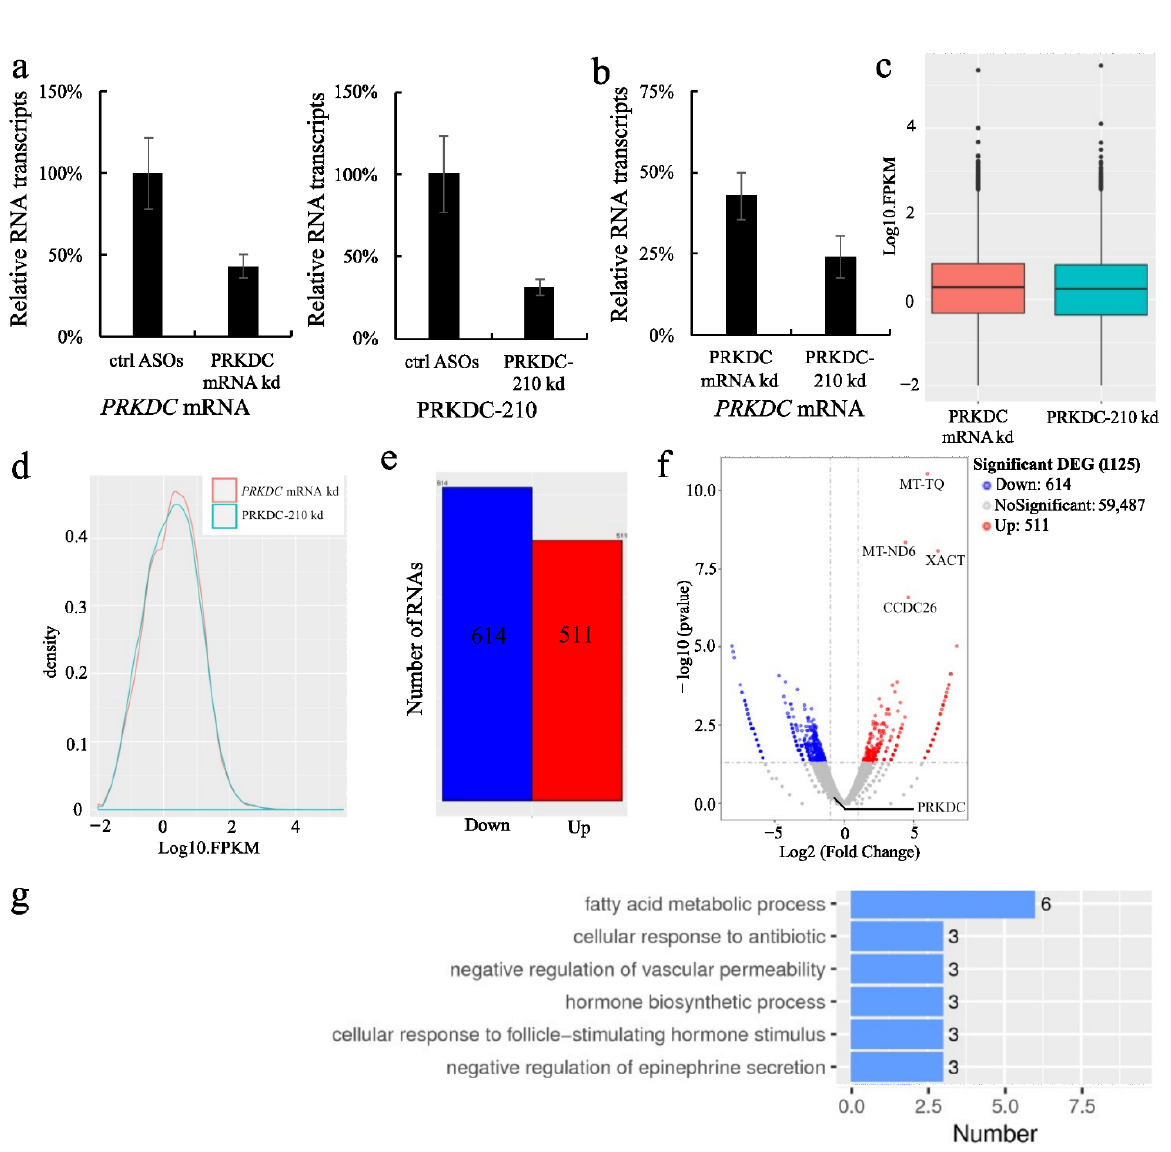
Figure 3. ( a , b ) Total RNA was extracted from MCF7 cells expressing control (ctrl) ASOs or ASOs targeting the PRKDC mRNA or PRKDC-210 , and the RNA transcripts levels were detected via RT- qPCR. Kd means knockdown. Data are represented as the mean ± s.e.m. of three independent ex-